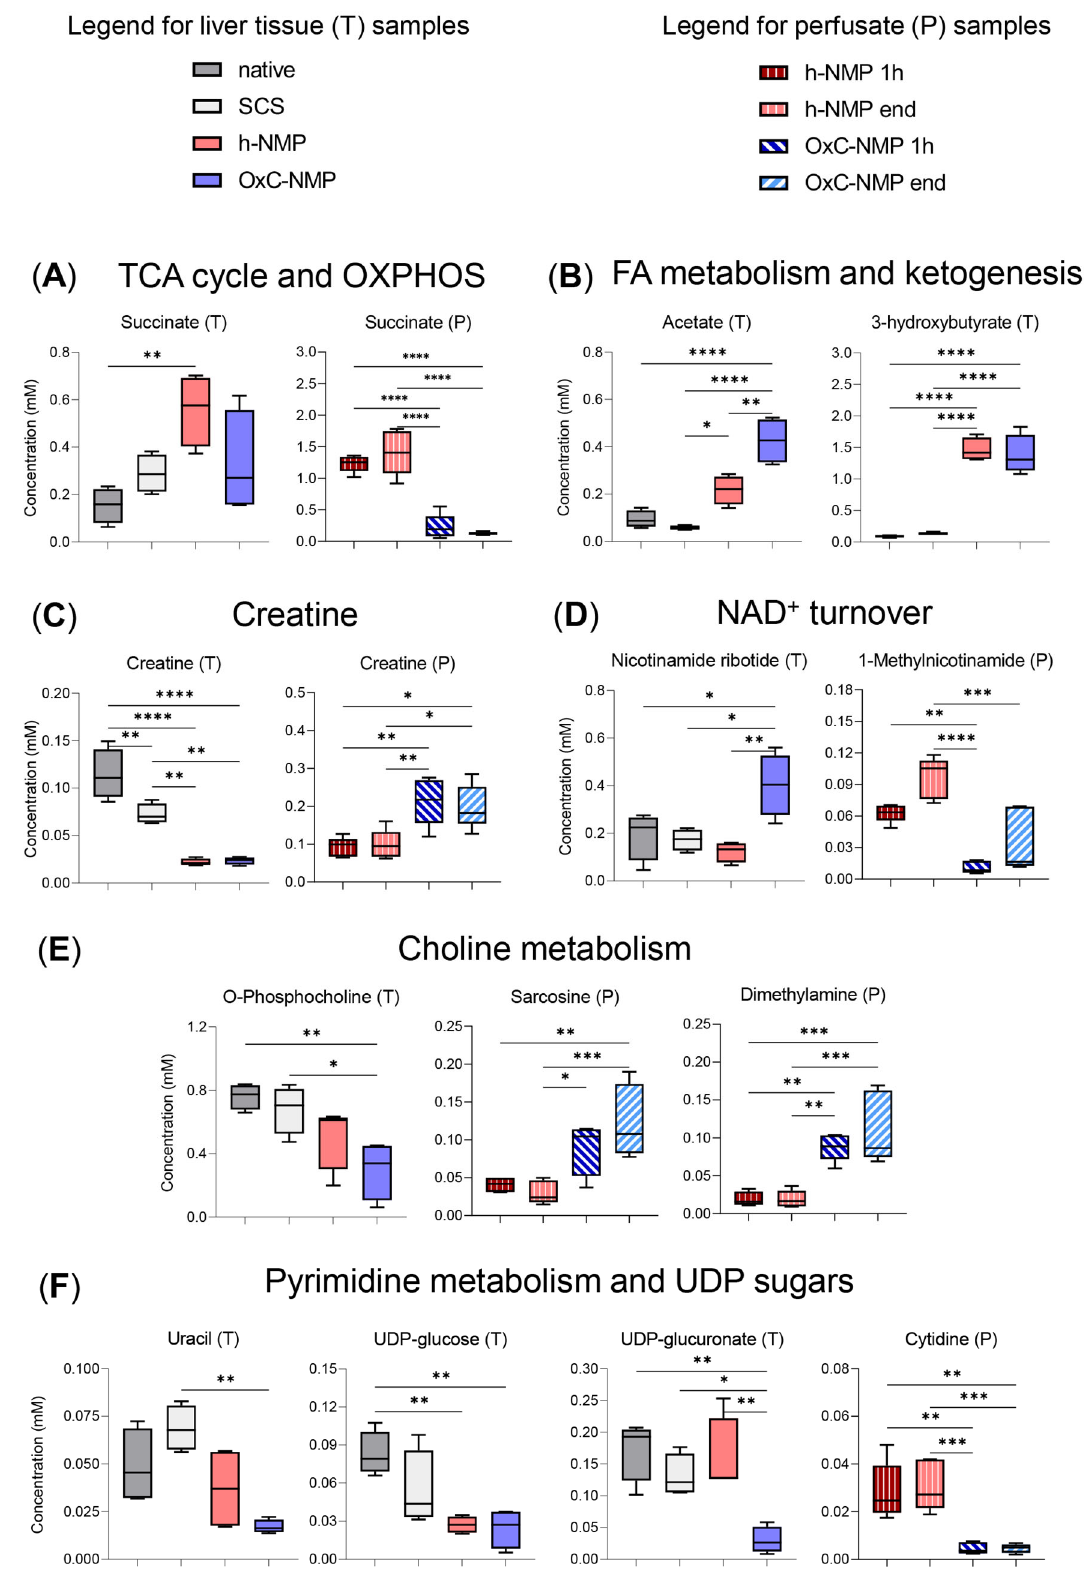
Figure 3. Differentially expressed metabolites in liver tissue and perfusate samples. Metabolic intermediates are grouped according to the following mitochondrial pathways: ( A ) tricarboxylic acid (TCA) cycle and oxidative phosphorylation (OXPHOS), illustrated by liver and perfusate suc ‐ cinate concentration box and whisker plot; ( B ) fatty acid (FA) metabolism and ketogenesis, illus ‐ trated by liver acetate and 3 ‐ HB; ( C ) creatine metabolism, illustrated by creatine concentration